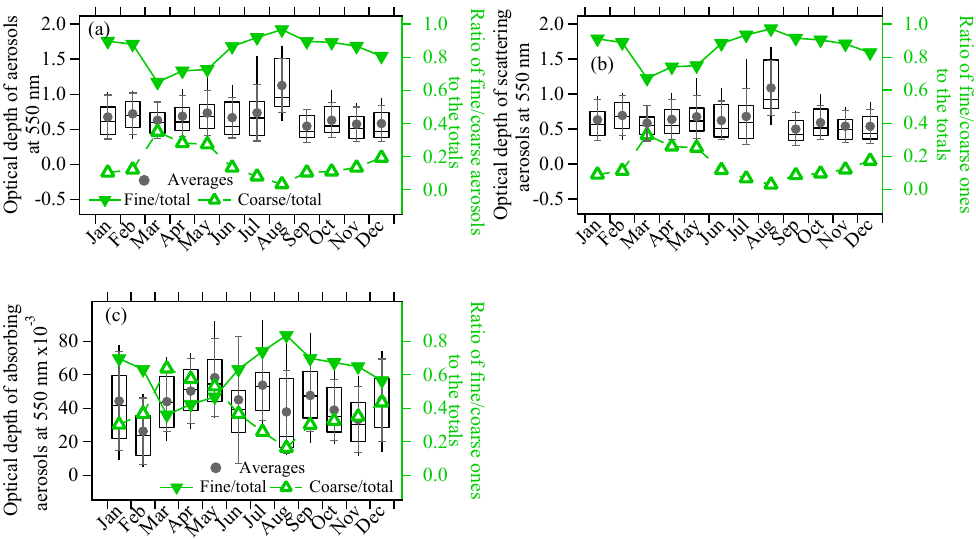
Figure 1. Monthly variations in the total (a) , scattering (b) and absorbing (c) aerosol optical depths (AOD) at 550nm, including the ratio of the AOD in fine or coarse mode to the AOD in all mode (line with triangle markers in green) in the urban area of Nanjing. The 10th, 25th, median, 75th, 90th percentile values of the all mode AOD are presented as box plots. The monthly means of the all mode AODs are presented as cycle markers in